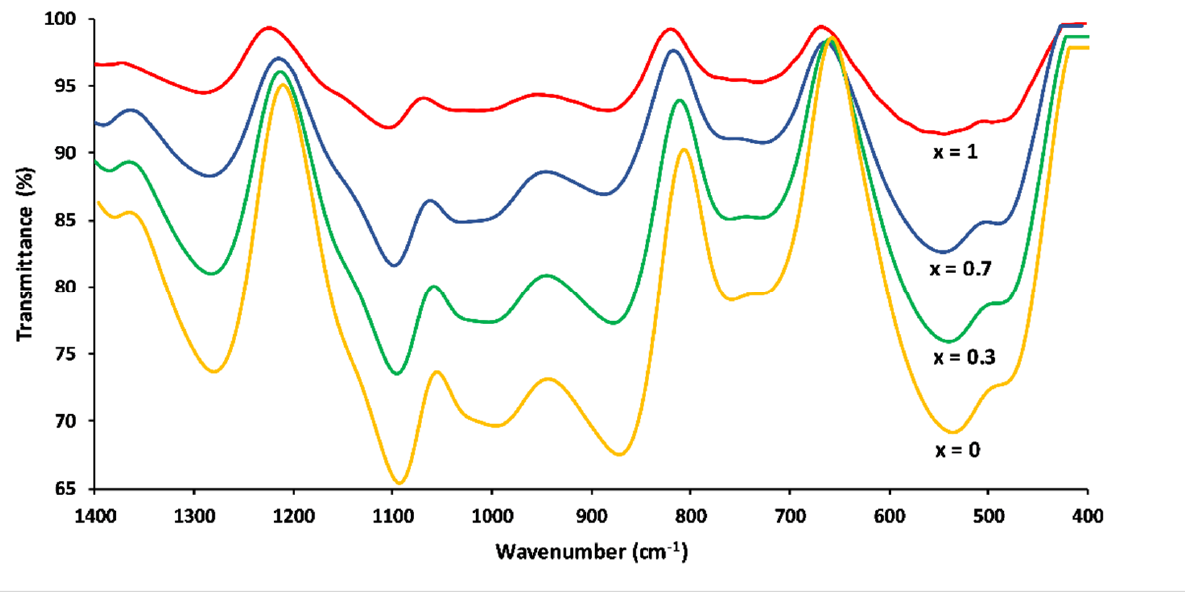
Figure 7. FTIR spectra of 3P 2 O 5 -2K 2 O-(1 − x)CaO-xMgO glasses for 0 ≤ x ≤ 1.